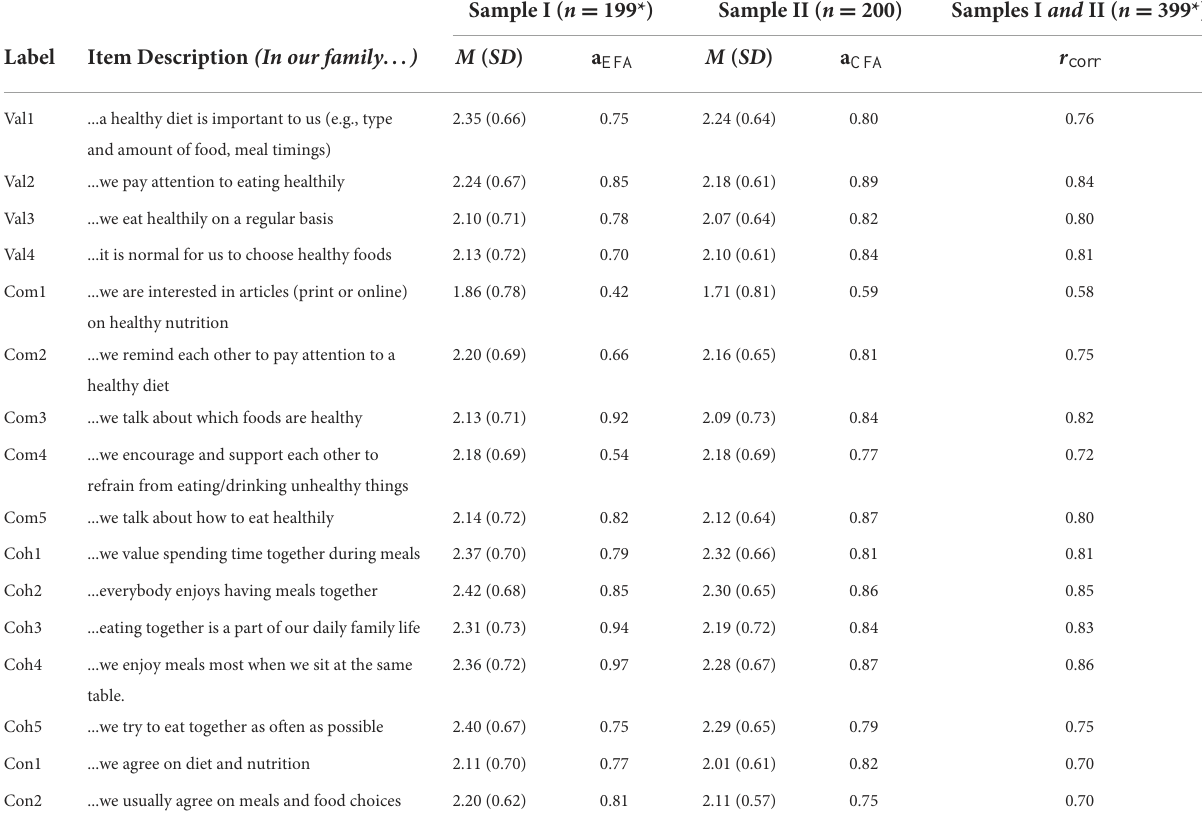
TABLE 2 Item descriptives, factors, and item parameters of FHC-NU